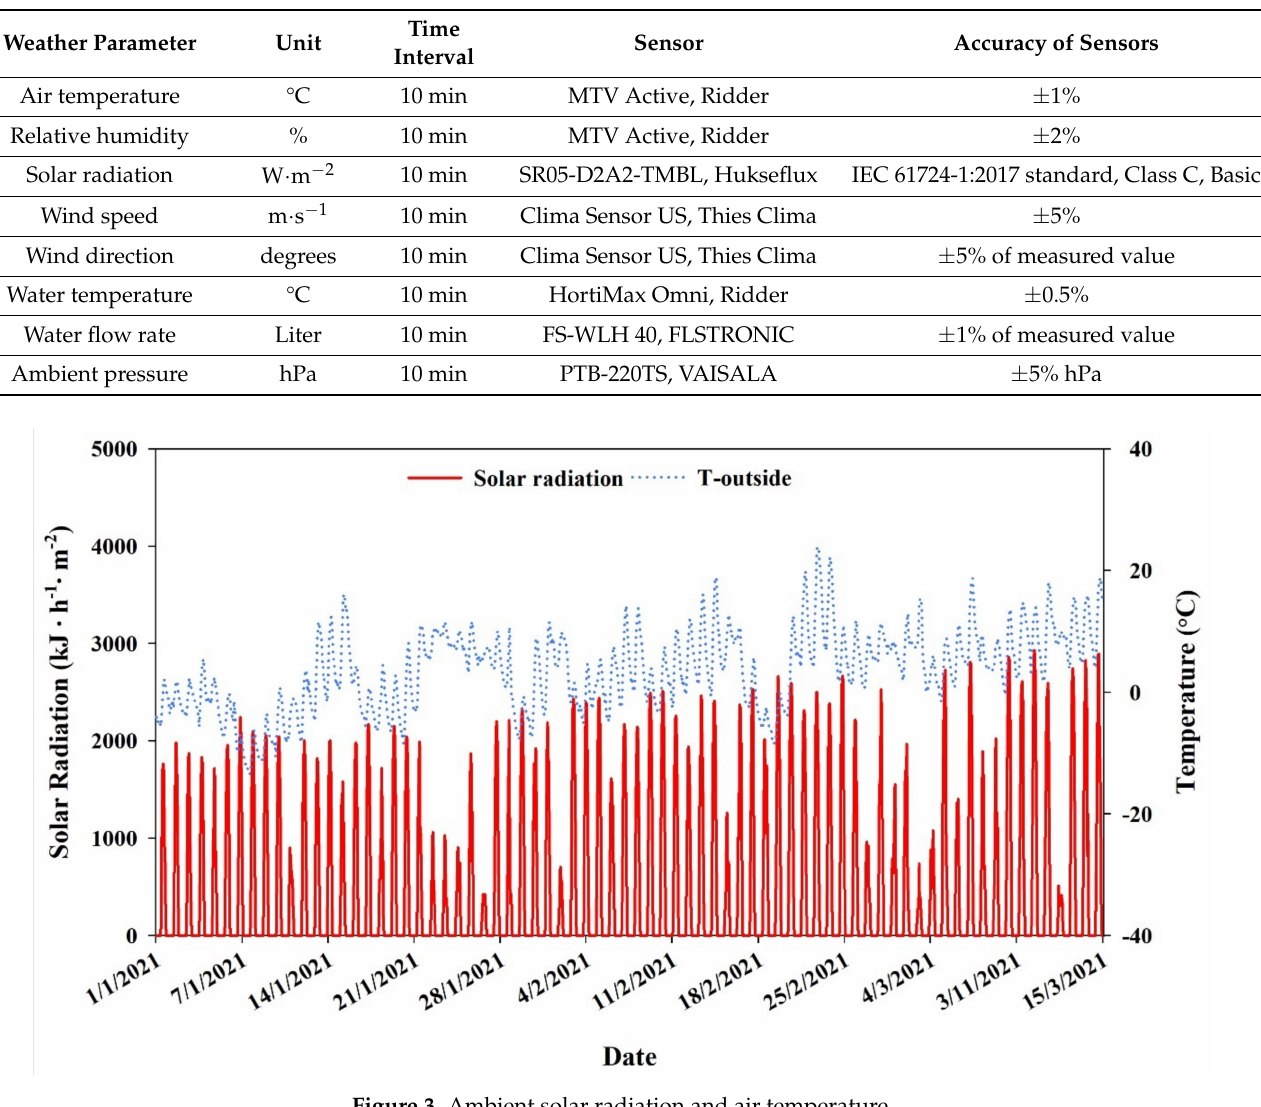
Figure 3. Ambient solar radiation and air